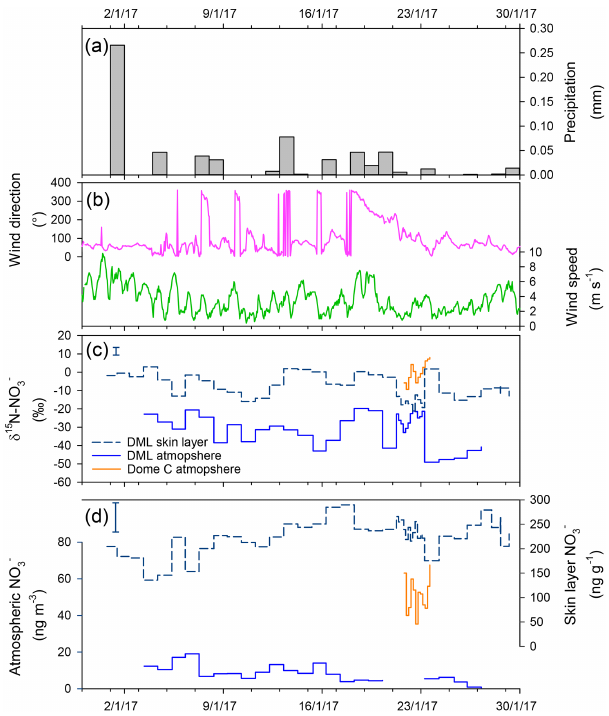
Figure 3. January 2017 time series in Dronning Maud Land (DML) of (a) daily precipitation, (b) hourly wind direction and wind speed, (c) atmospheric and skin layer δ 15 N-NO − , and (d) atmospheric and 3 Figure 4. Comparison of NO − mass concentration and δ 15 N-NO − skin layer NO − mass concentration. Error bars in panels (c) – (d) in- 3 3 3 at Dronning Maud Land (DML) and Dome C in January 2017. NO − dicate the spatial variability in the site determined by multiple skin 3 mass concentration in (a) atmosphere, (b) skin layer, and (c) depth layer samples collected on 28 January 2017. The spatial variabil- profiles. Insert: depth profile of NO − mass concentration high- ity exceeds the instrumental error, which is smaller than the sym- 3 bol size. Meteorological data source: University of Utrecht (AWS9; lighting seasonal variability. δ 15 N-NO − in (d) atmosphere, (e) skin 3 DML05/Kohnen; 75 ◦ 00 (cid:48) S, 00 ◦ 00 (cid:48) E/W; ∼ 2900ma.s.l.). Precipi- layer, and (f) depth profiles. Grey bars indicate summer seasons for tation data source: RACMO2 (https://doi.org/10/c2pv, van de Berg DML depth et al., 2019).